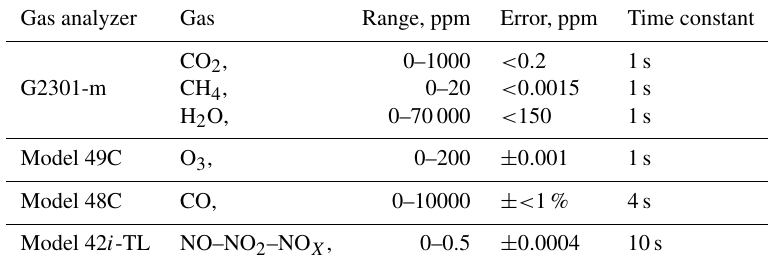
Table 1. Technical characteristics of the gas